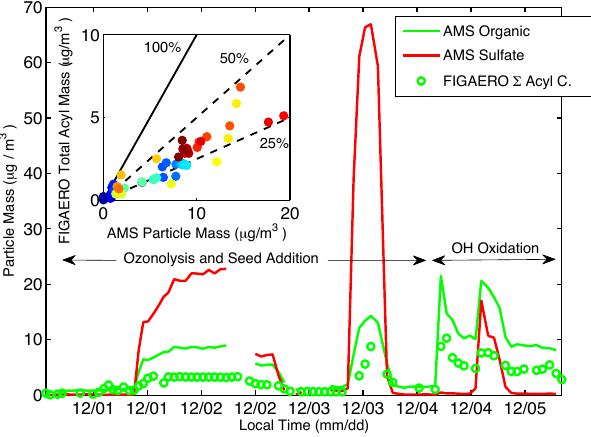
Figure 2. An overview of the experiments conducted in the JPAC chamber. Green and red lines are total organic and sulfate mass concentrations measured by an HR-AMS. The total organic aerosol mass detected by the AMS responded to changes in seed concentra- tions, increasing the inferred SOA yield. Size selected ammonium sulfate additions were performed to increase the particle surface area relative to chamber walls. The sum FIGAERO–HR-ToF-CIMS particulate mass using acetate reagent ions is shown in green circles using the formic acid sensitivity for all detected compositions (see text for details). Inset: correlation between the HR-AMS-derived total organic aerosol mass concentrations and the FIGAERO–HR- ToF-CIMS-derived total “acyl”-containing compound mass concen- trations shows that across all chamber conditions the FIGAERO measurements explain 25–50% of the total organic aerosol